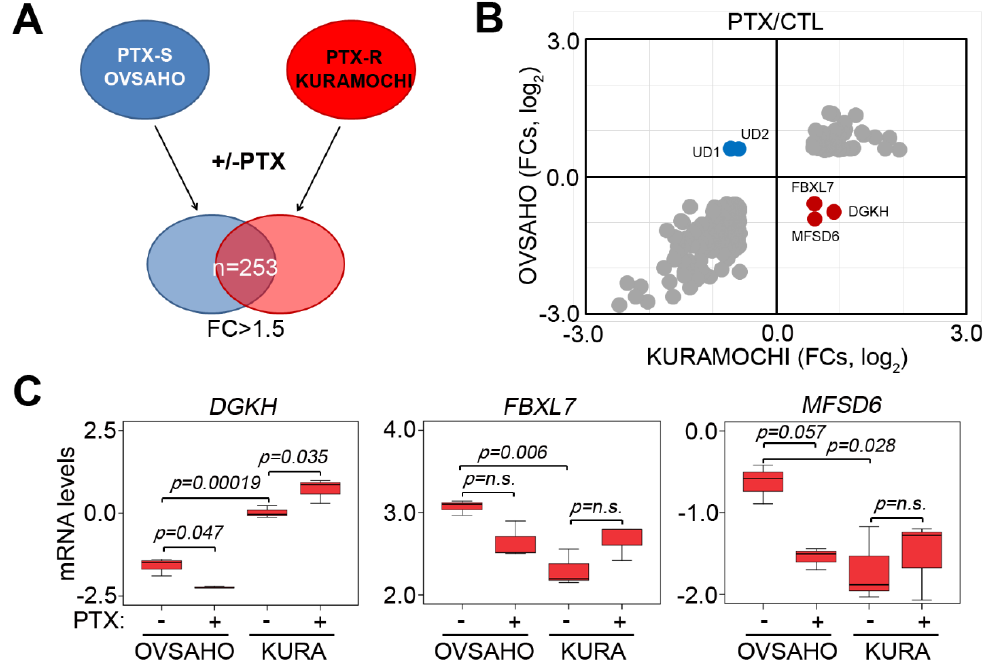
Figure 1. Upregulation of DGKH , FBXL7 , and MFSD6 involved in the mechanism underlying Paclitaxel (PTX) resistance in PTX-insensitive ovarian cancer cells. ( A ) A flowchart for identifying consensus genes with 1.5-fold change (FC) posttreatment with PTX at the concentration of 10 × IC 50 for 24 h in PTX-sensitive (PTX-S) OVSAHO cells and PTX-resistant (PTX-R) KURAMOCHI cells. ( B ) The dotplot for the mRNA levels (log 2 ) of 253 consensus genes identified as the strategy shown in ( A ). ( C ) The mRNA levels of DGKH , FBXL7 and MFSD6 in OVSAHO and KURAMOCHI cells post-treatment without or with PTX at the concentration of 10 × IC 50 for 24 h. Data from three independent experiments are shown as the median ± SD. The significant differences were analyzed by one-way ANOVA using Turkey’s